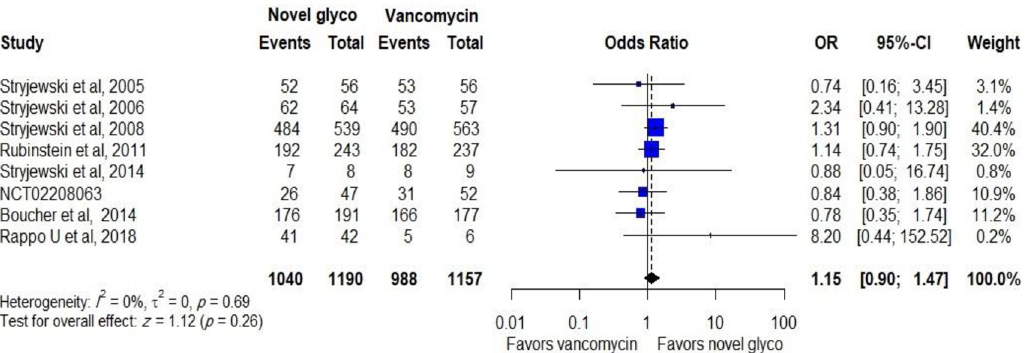
Fig 4. Clinical response of novel glycopeptides against vancomycin in the microbiological evaluable populations with MRSA.